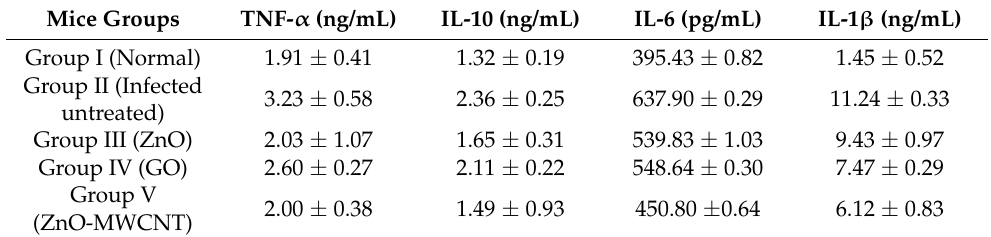
Table 3. Inflammatory response of the infected and non-infected mice